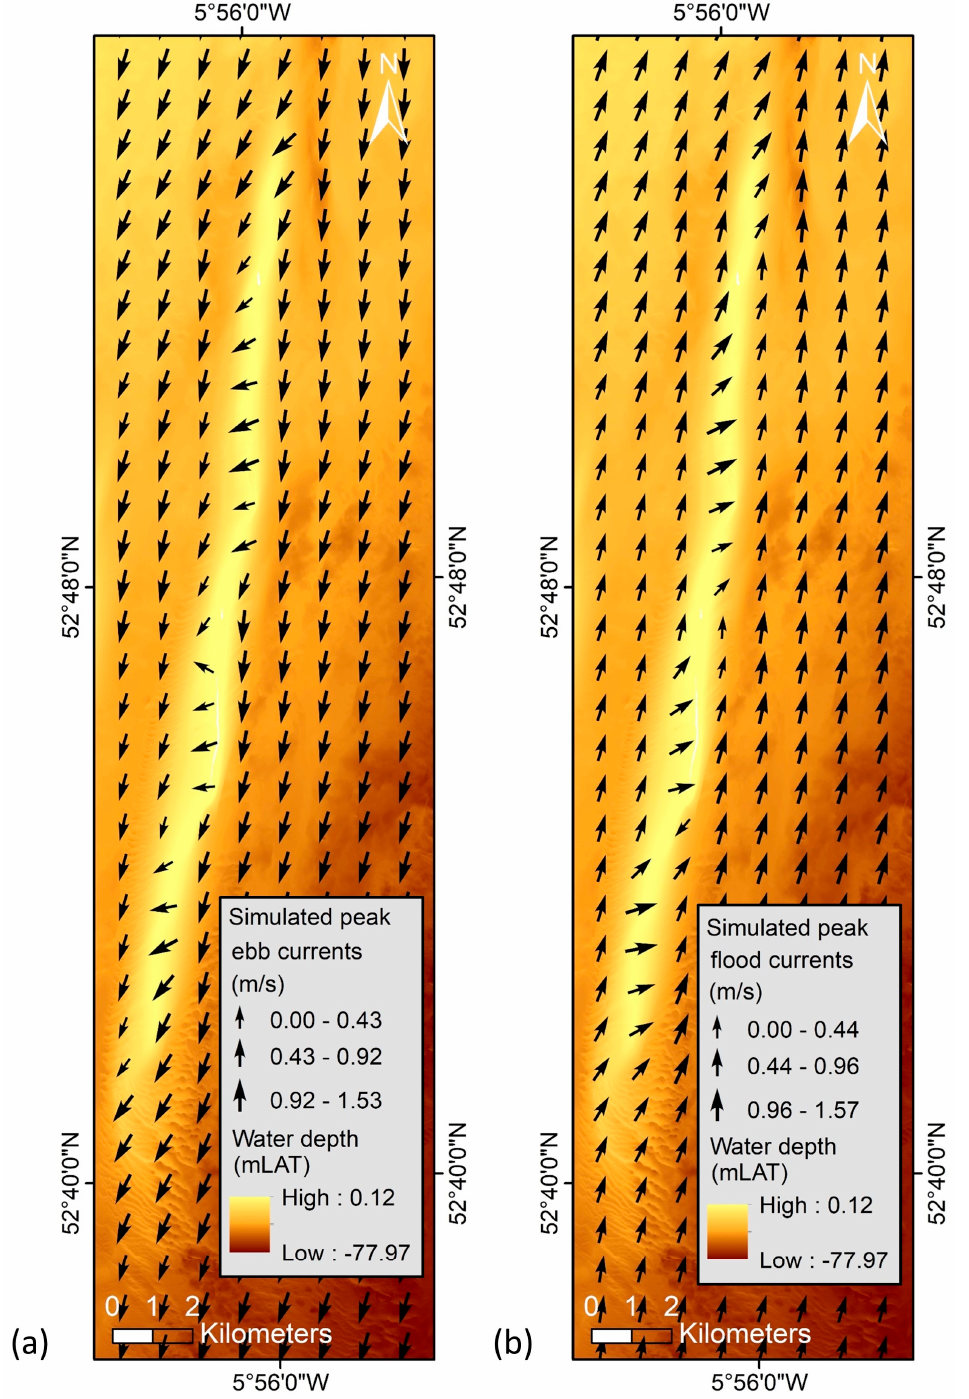
Figure 4. ( a , b ) Simulated peak ebb and flood depth-averaged currents, respectively. Bathymetry